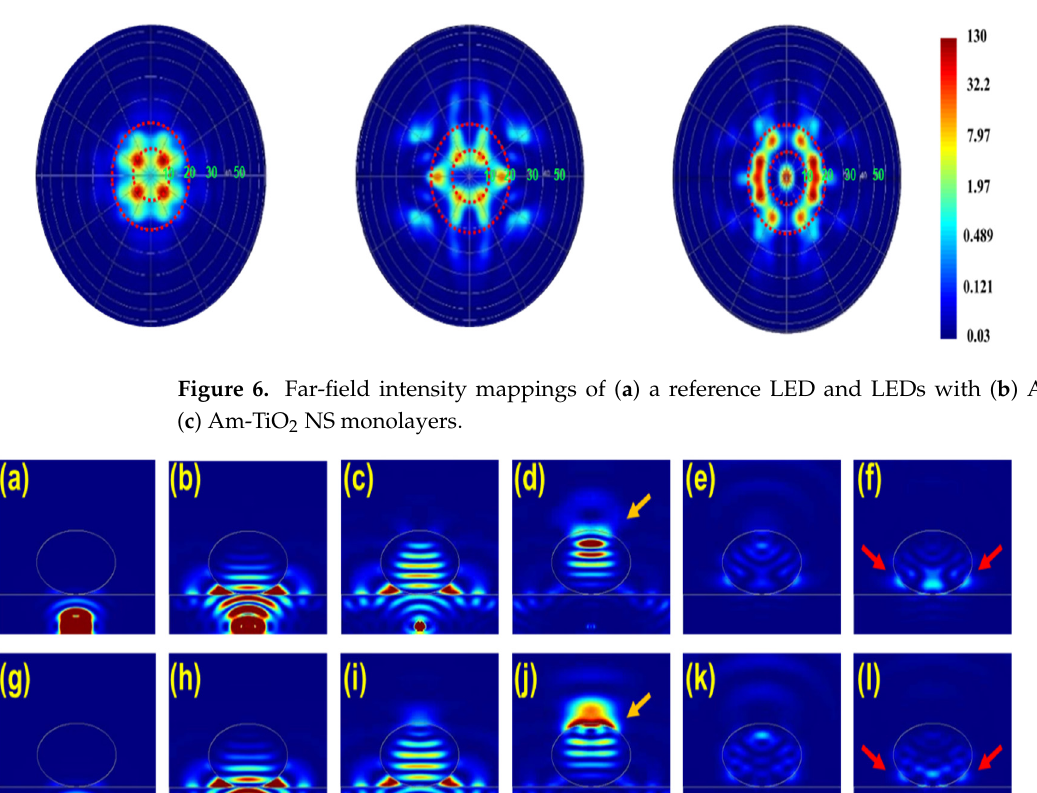
Figure 6. Far-field intensity mappings of ( a ) a reference LED and LEDs with ( b ) An-TiO 2 and ( c ) Am-TiO 2 NS monolayers.